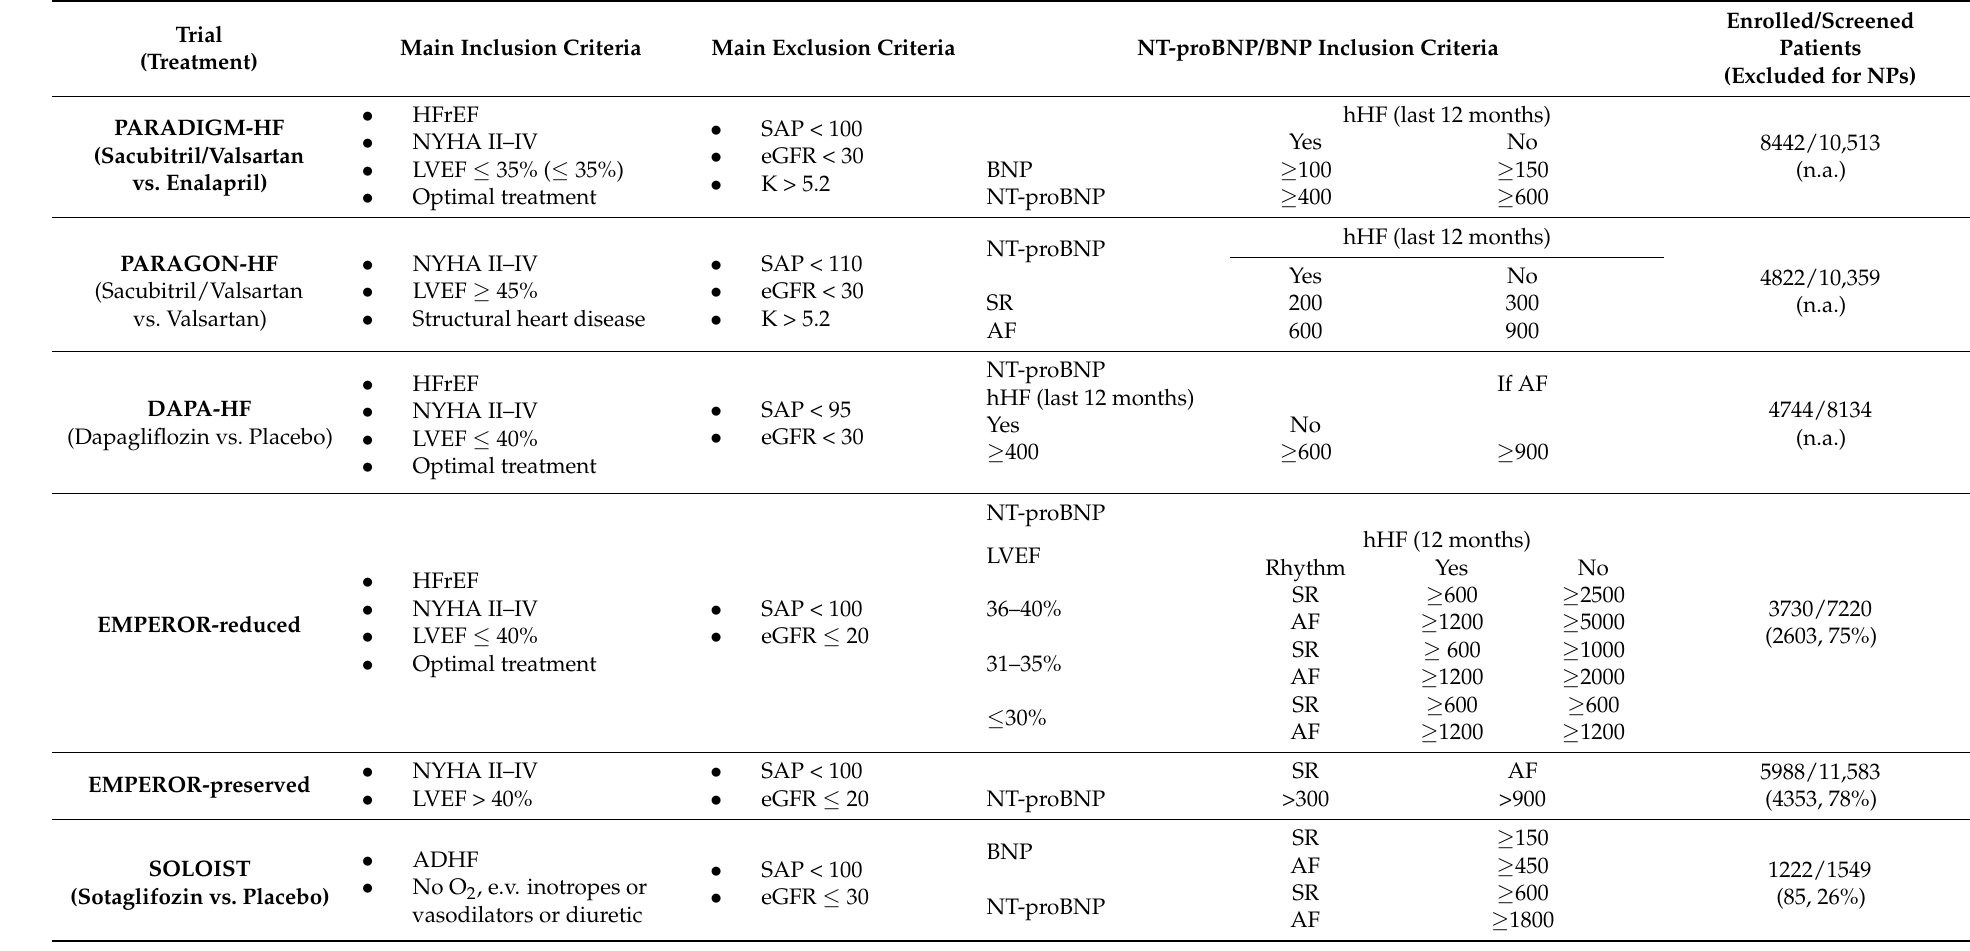
Table 2. Inclusion criteria of the more recent randomized trials evaluating treatment of HFrEF. The criteria based on natriuretic peptides are